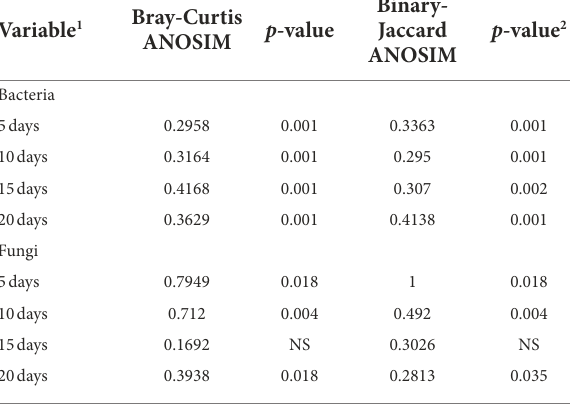
TABLE 4 Similarity analysis of fecal bacteria and fungi in weaned Holstein calves with different concentrations of FMT (ANOSIM). Bray-Curtis Variable 1